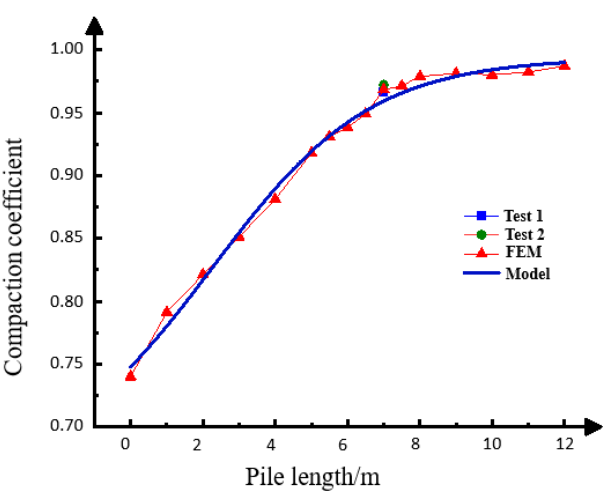
Figure 7. The relationship between the compaction coefficient and H.